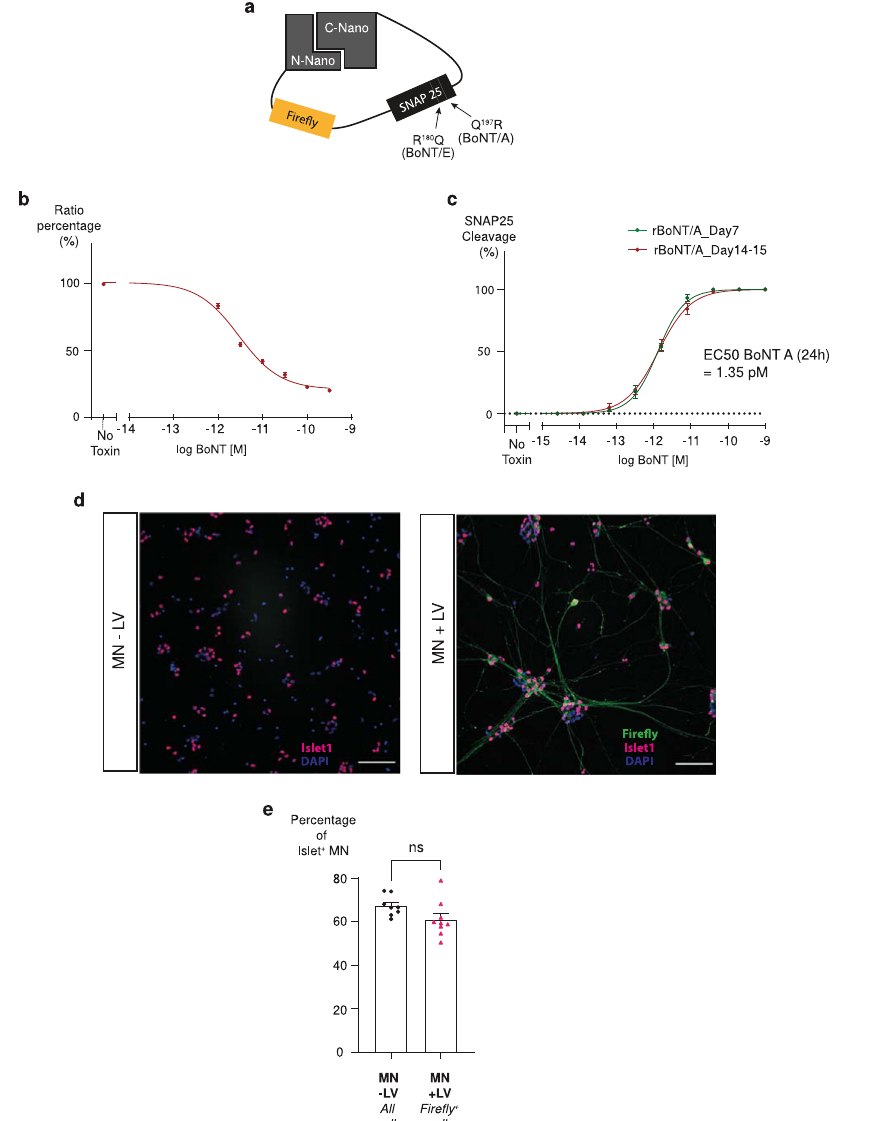
Fig. 2 Split NanoLuc ™ luciferase sensor can be used in rodent and human neurons. a Schematic representation of BoNT sensor4 construct. The split NanoLuc TM luciferase is linked together by a linker containing the Fire fl y luciferase and SNAP-25. The cleavage sites for BoNT/A and E are indicated. b Detection assay of BoNT/A using virus-transduced rodent neuronal cells. The remaining luciferase activity was measured. Assay was performed in triplicate. c Comparison of iCell MN toxin sensitivity to BoNT/A at day 7 (green circles) and day 14 – 15 (red circles). Graph shows the dose – response curve of SNAP-25 cleavage. Data points are mean of n = 3 independent experiments performed in triplicate. d , e Impact of lentiviral transduction (MOI 16) on MN identity 6 days after transfection. ISLET1-positive and Fire fl y-positive MNs were counted. d Immunostaining of DAPI (blue), Islet1 (purple) and Fire fl y (green) in iCell MN. Scale bar 100 µ m. e Graph showing quanti fi cation of the percentage of Islet positive cells (Islet + cells/DAPI + cells) in the non- transduced conditions (black circles) and the percentage of Islet positive cells in the fraction of Fire fl y-positive cells in the transduced conditions (pink triangles). The percentage of Islet + cells in the indicated conditions represented a mean of 8 wells per conditions ( ≥ 750 cells were counted per well). Statistical two-tailed Student ’ s t -tests: * P < 0.05; ** P < 0.01; *** P < 0.001; NS, P > 0.05 not signi fi cant (NS). Error bars show